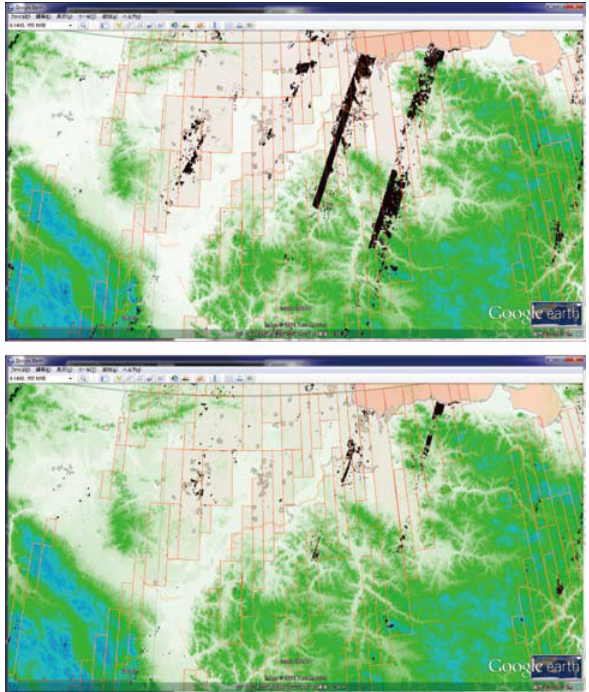
Figure 4. Example of GDEM image (north-eastern Russia) with the AOIs of data acquisition requests Black areas indicate bad pixels, upper : GDEM version 1 image with the AOIs (red rectangles) of data acquisition requests for GDEM version 2, lower : GDEM version 2 image with the AOIs (red rectangles) in the GDEM-2 DAR